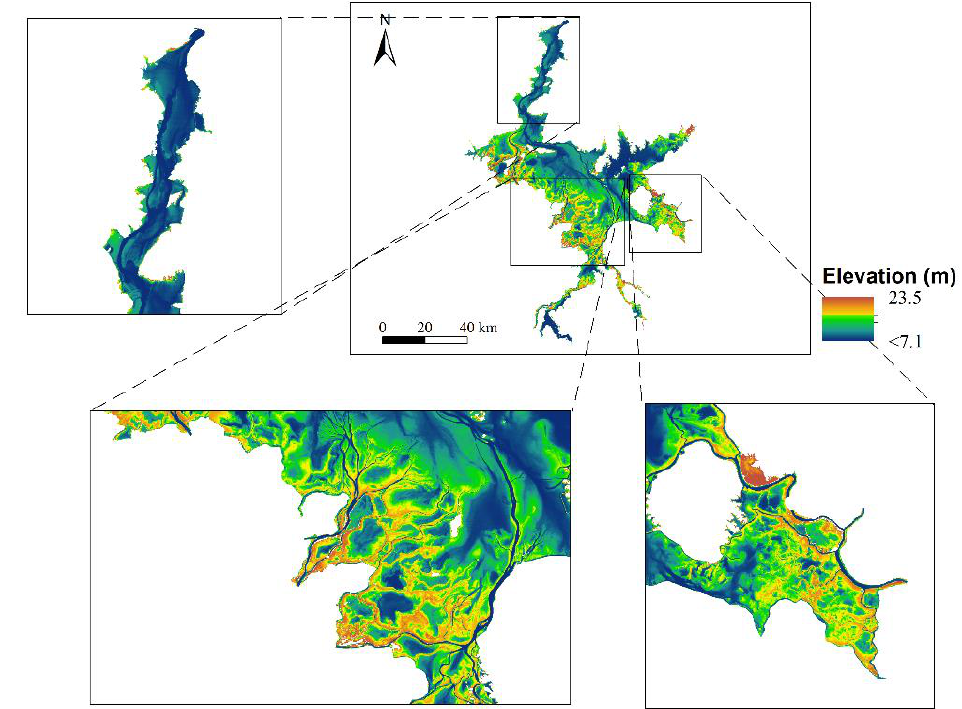
Figure 8. Bottom topographic map of Poyang Lake derived from the proposed method.